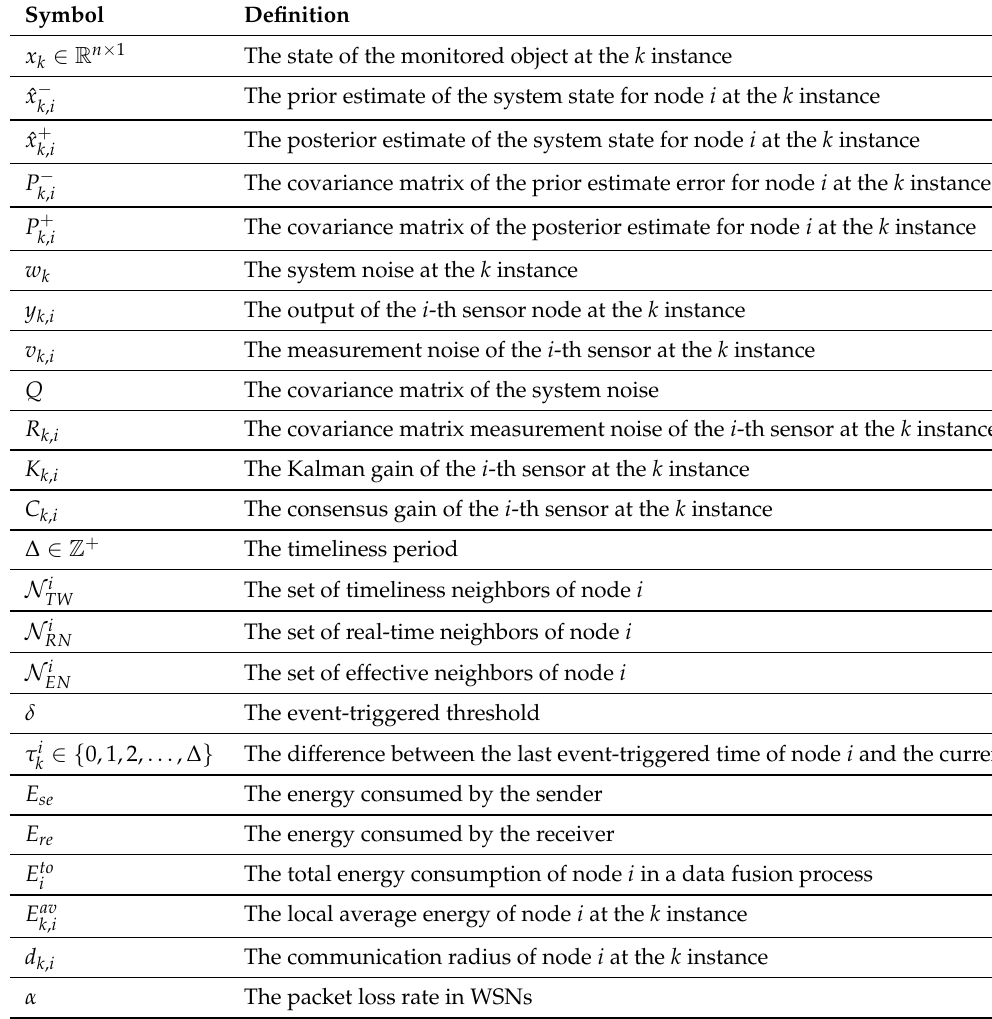
Table 1. List of important